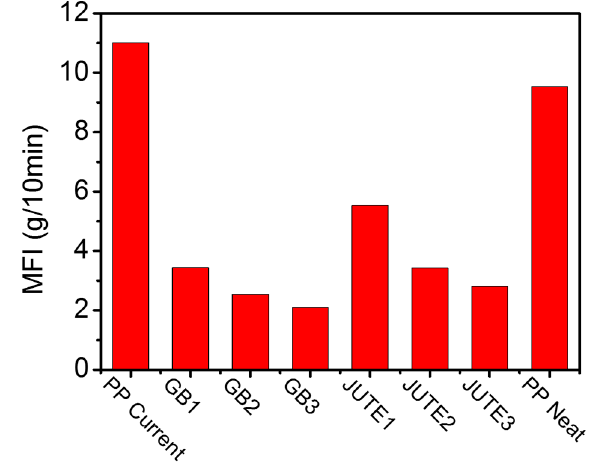
Figure 4. Melt flow index (MFI) values for different materials.